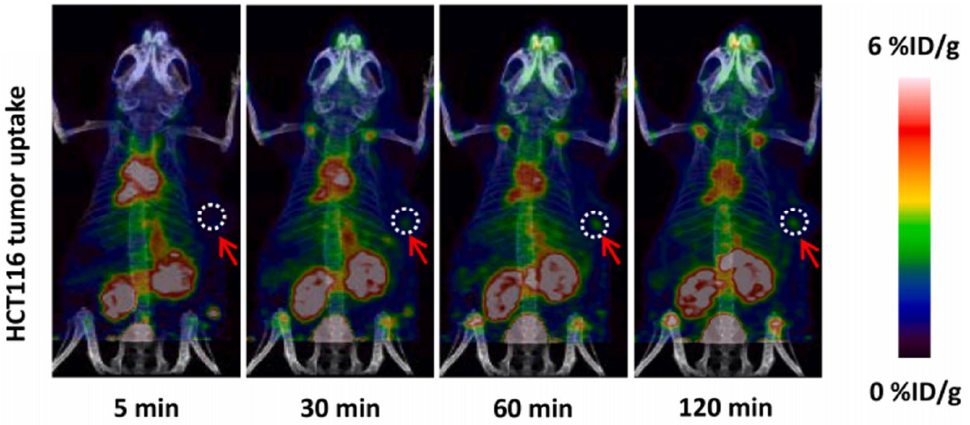
Figure 10. Micro PET/CT images of [ 18 F]AlF-NOTA-IPB-PDL1P in a HCT116 mouse tumor model. Reprinted/adapted with permission from Ref. [62]. 2022 Elsevier Inc.